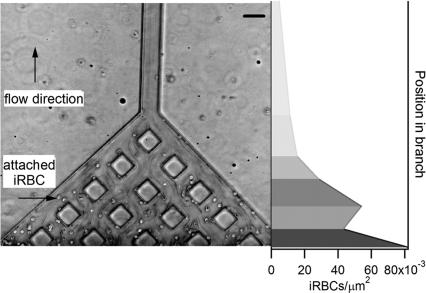
Preferential Attachment of iRBCs in Regions of Lower Fluid Shear StressIn a network of capillaries coated with CD36, a larger number of iRBCs attach in the branches, where shear stress is lower than in the main channel. Applied pressure is 1 kPa across the entire network, making the pressure in individual branches low enough for iRBCs to bind to CD36 in a stationary manner rather than rolling. Image was taken after approximately 10 min of continuous flow.Scale bar = 50 μm.